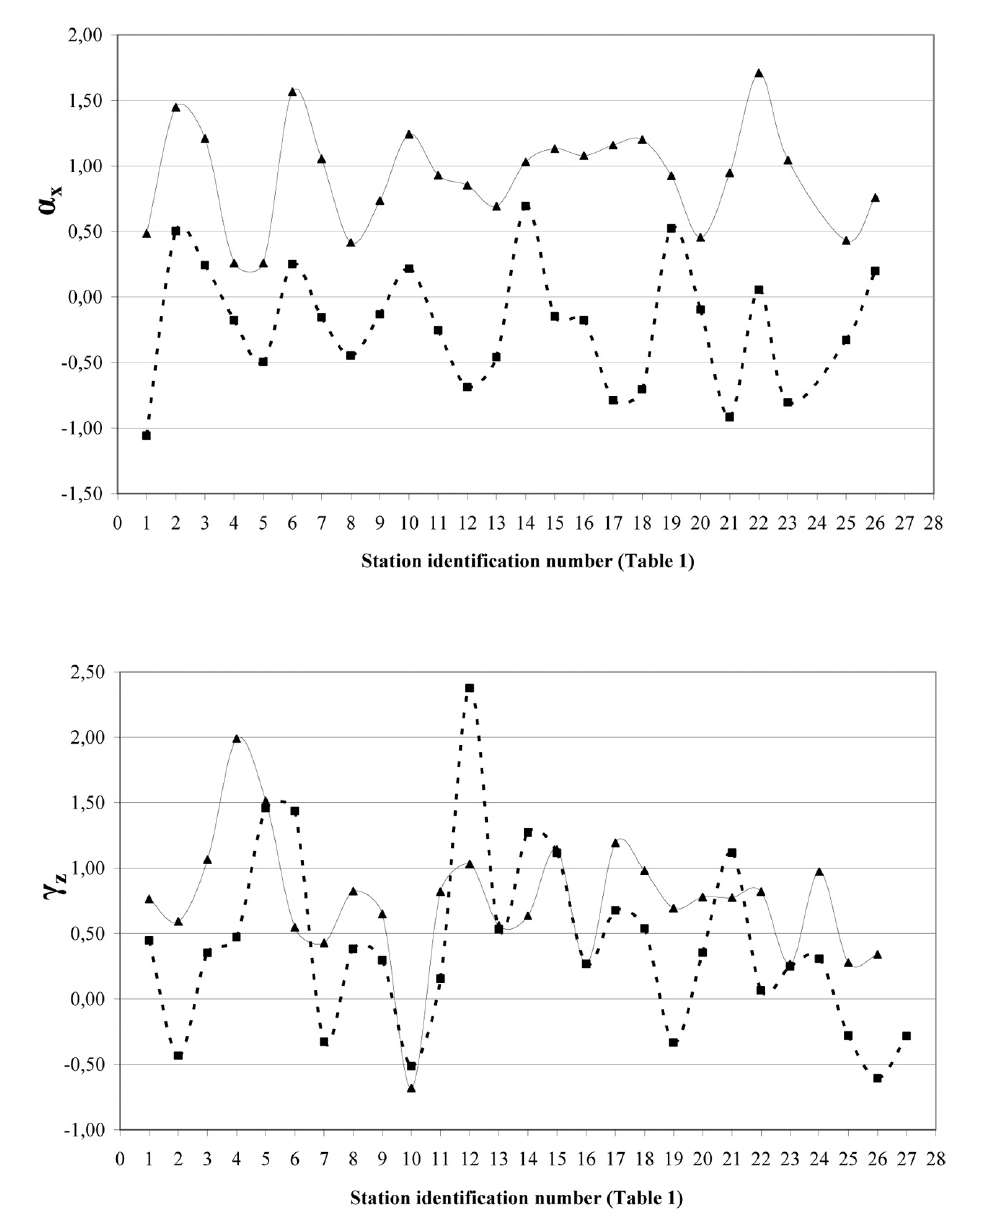
and c using as proxy for the inducing force SUA (full line) and NGK (broken x z